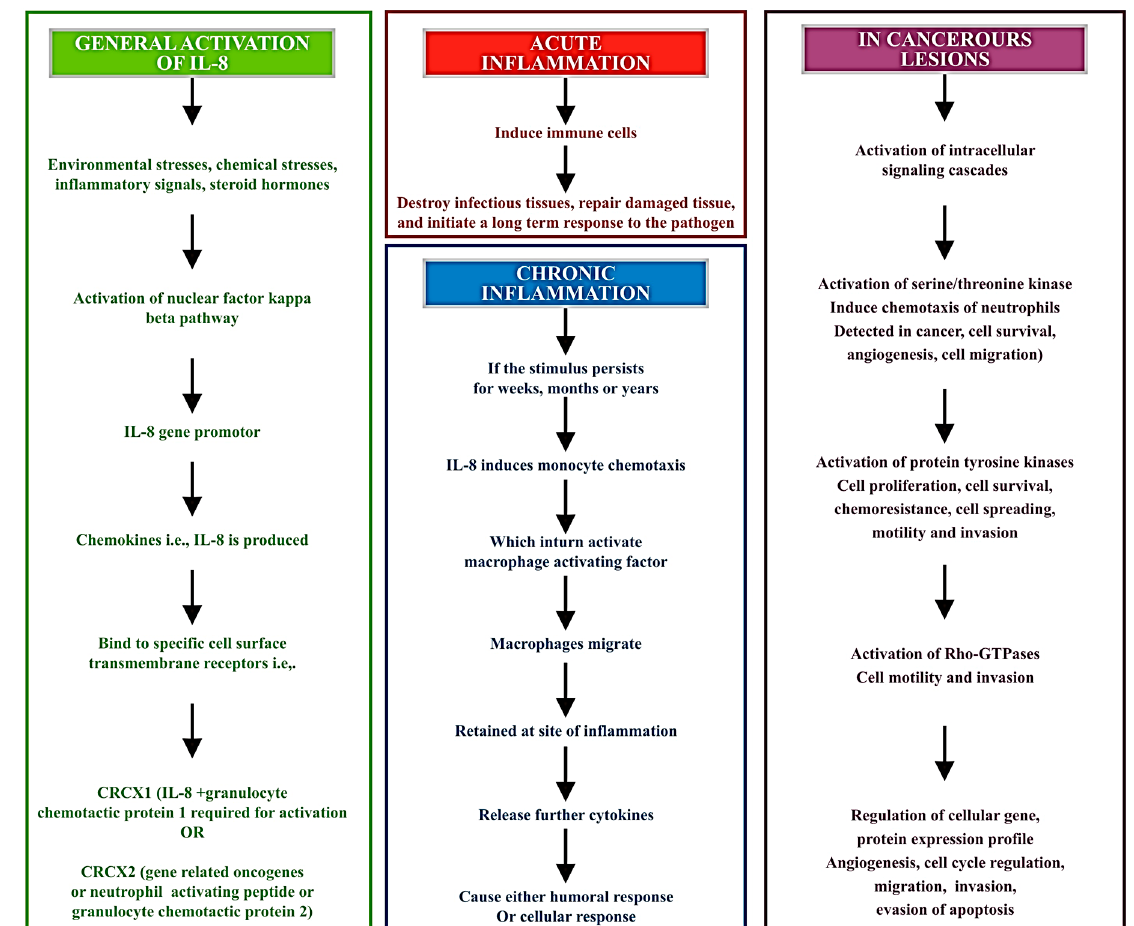
Figure 3. Pathways involved in activation and release of IL-8 and their effects at cellular level.